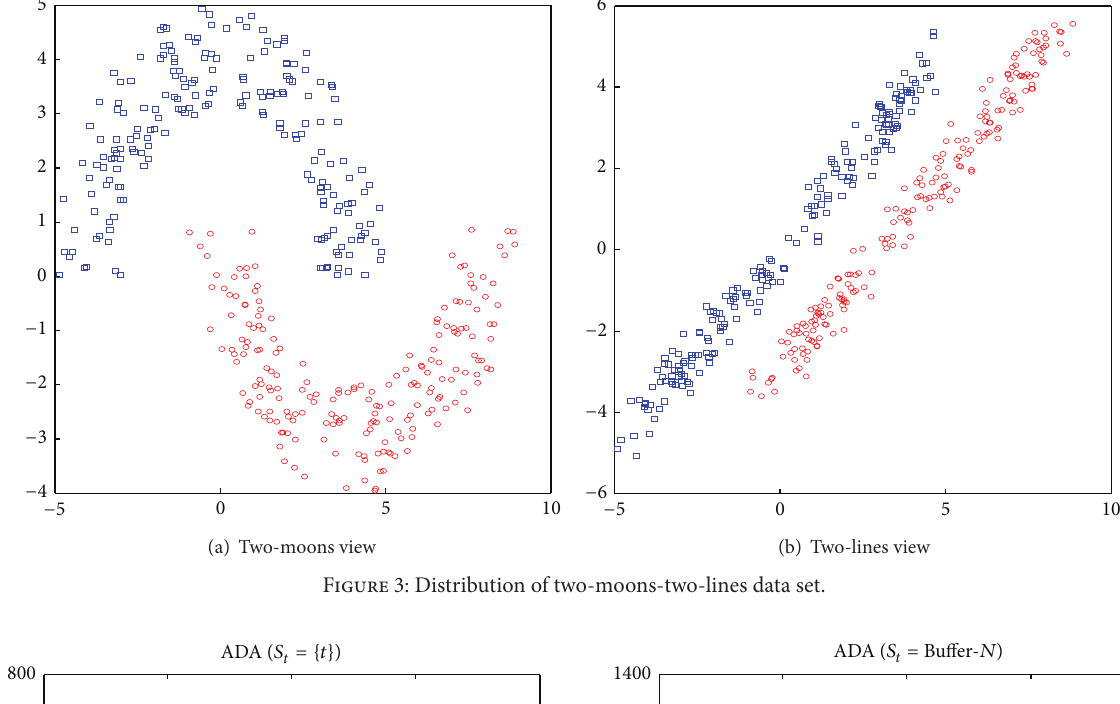
Figure 3: Distribution of two-moons-two-lines data set.